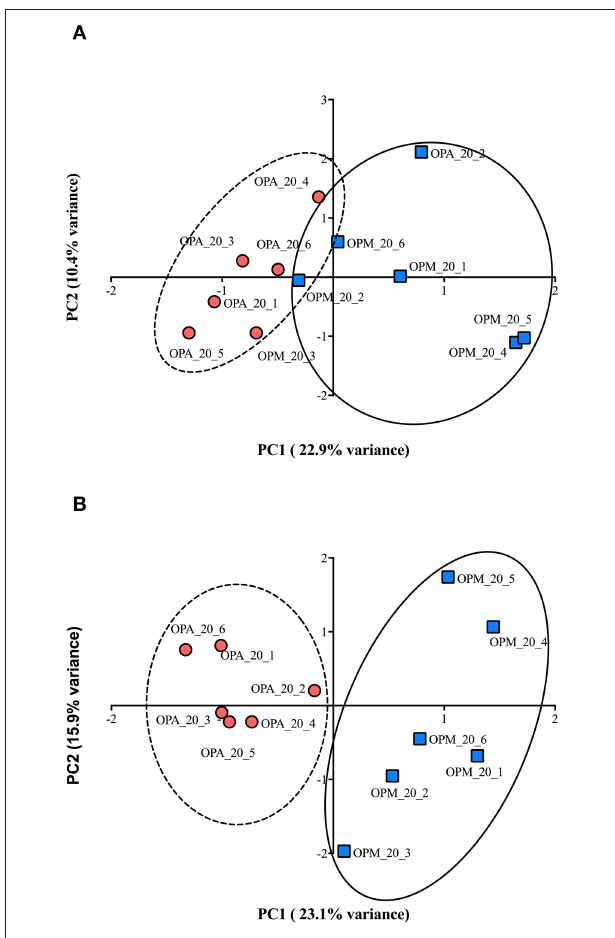
FIGURE 6 | (A) Principal Components Analysis for 20 days post-hatching paralarvae of O. vulgaris fed on improved mixed diet (M) and Artemia -based diet A. Representation of the similarity of all quantified proteins (2,341) among the 6 individual per diet analyzed by SWATH-MS. (B) Representation of the similarity of 43 proteins with significant changes in abundance related to